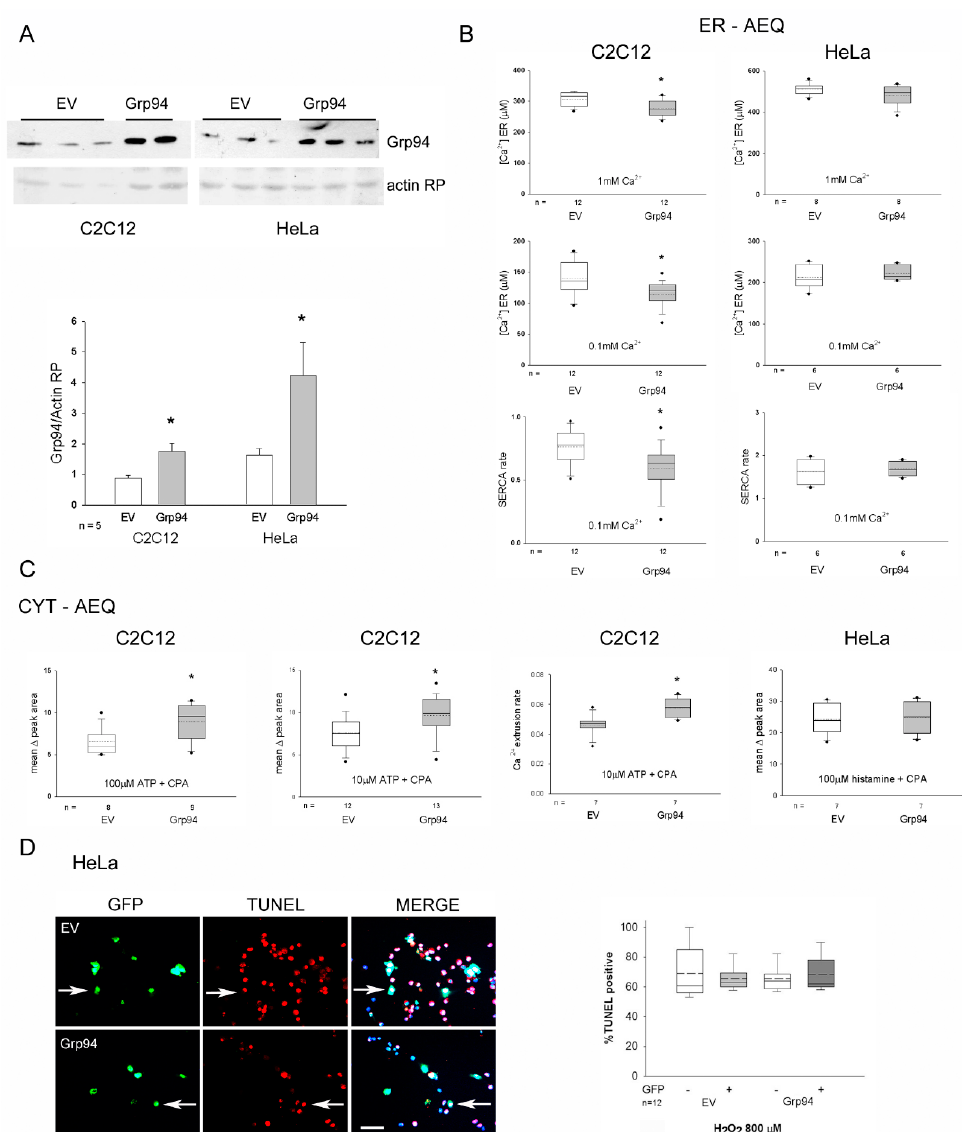
Figure 1. Grp94/gp96 overexpression differently affects Ca 2+ -homeostasis and antioxidant protection in C2C12 and HeLa cells. ( A ) Representative Western blots showing Grp94 immunoreactivity in whole homogenates from transiently transfected cultures with empty vector (EV) or Grp94 cDNA. ( B ) Values of ER Ca 2+ levels determined on EV and Grp94 overexpressing cultures (C2C12 and HeLa) after co-transfection with the ER-AEQ construct and exposure to 1 mM and 0.1 mM Ca 2+ (upper and middle panels). Lower panels represent rate of SERCA activity, calculated in the presence of Ca 2+ 0.1 mM, as described in the Methods section. * p ≤ 0.02. ( C ) Values of average peak area of cytosolic Ca 2+ rise (left and right panels) and Ca 2+ extrusion rate (middle), determined on EV and Grp94 overexpressing cultures (C2C12 and HeLa), after co-transfection with the CYT-AEQ construct and exposure to 100 or 10 µ M ATP, or histamine, plus 20 µ M CPA in the absence of extracellular Ca 2+ . * p ≤ 0.03. ( D ) Left panel: Representative immunofluorescence images of HeLa cells transfected with EV or Grp94 cDNA (green fluorescence due to GFP expression) analyzed for the presence of apoptosis by means of TUNEL (red fluorescence) after exposure to 800 µ M hydrogen peroxide for 5 h. Arrows indicate transfected apoptotic cells. Bar: 30 µ m. Right panel: Box plots of the percentage of TUNEL positive nuclei calculated on the total amount of GFP-positive cells (about 100 cells for each slide); percentages were also calculated for non-transfected cells (about 300 cells for each slide). n indicates the number of cultures examined from at least two different